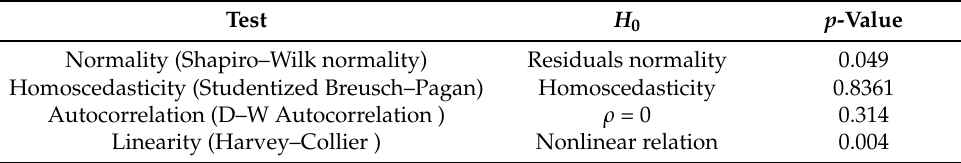
Table A3. Tests results for the final forecast model’s diagnostic